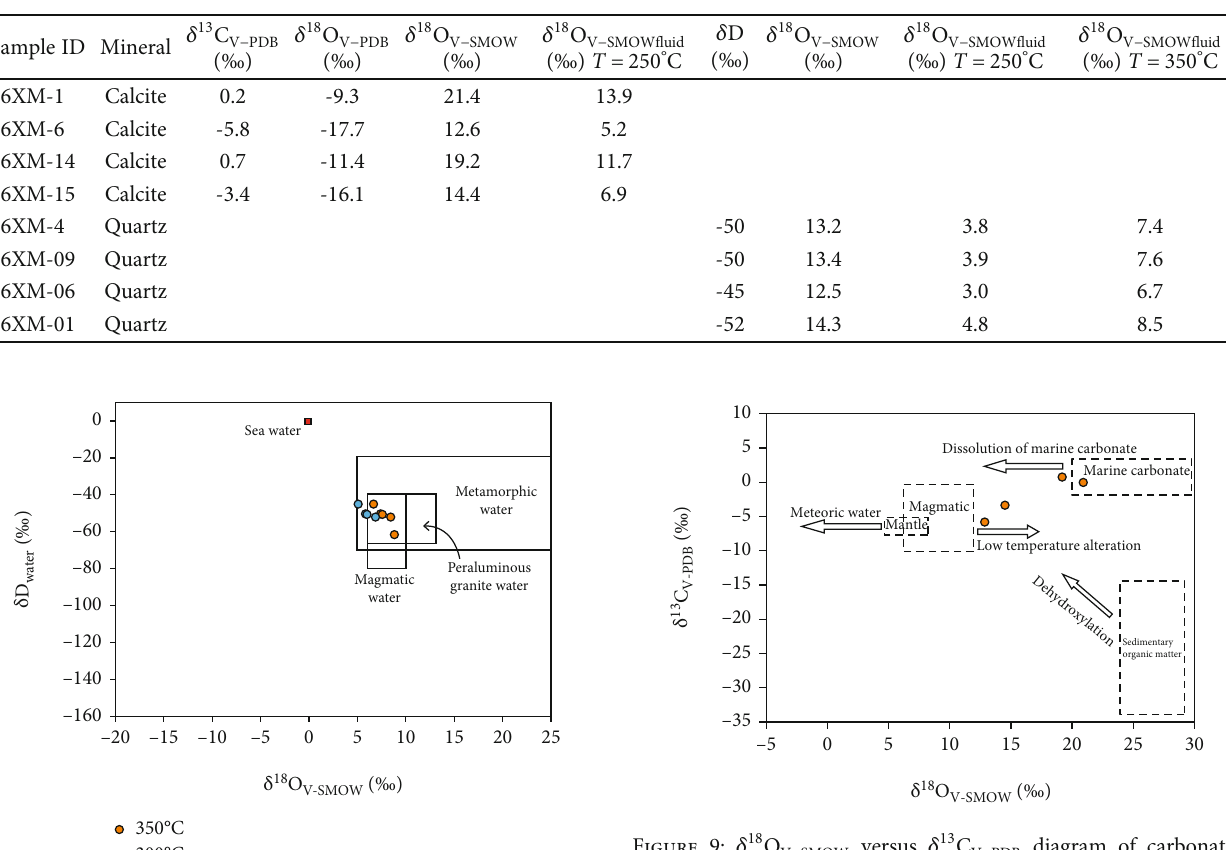
Figure 7: Microphotography showing the change in δ 34 S values ( ‰ ) of pyrrhotite, sphalerite, and galena. Mineral abbreviations (after [19]): Ccp: chalcopyrite; Gn: galena; Po: pyrrhotite; Py: pyrite; Sp: sphalerite. Table 2: Carbon, hydrogen, and oxygen isotope data of calcite and quartz from the Xinmin deposit.